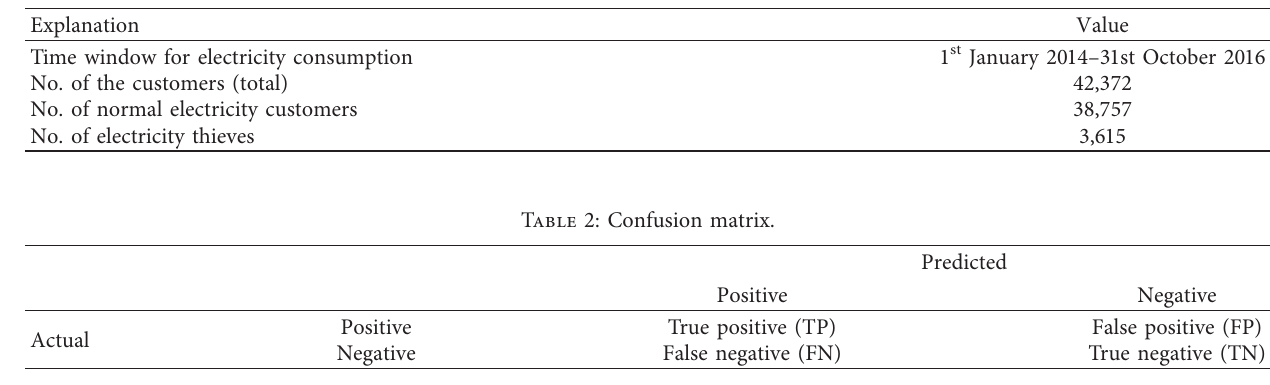
Table 1: Data description.